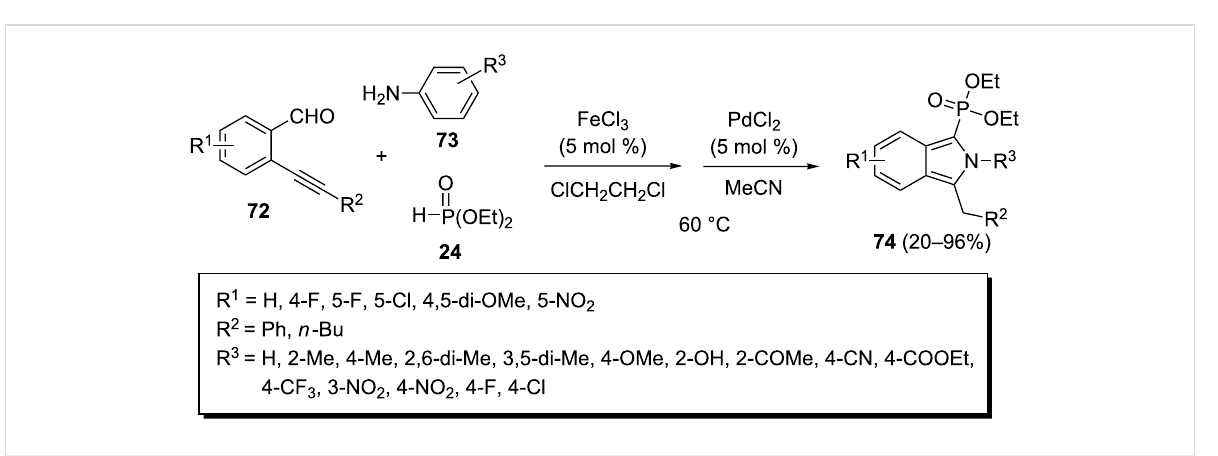
Scheme 18: FeCl 3 and PdCl 2 co-catalyzed three-component reaction of 2-alkynylbenzaldehydes, anilines, and diethyl